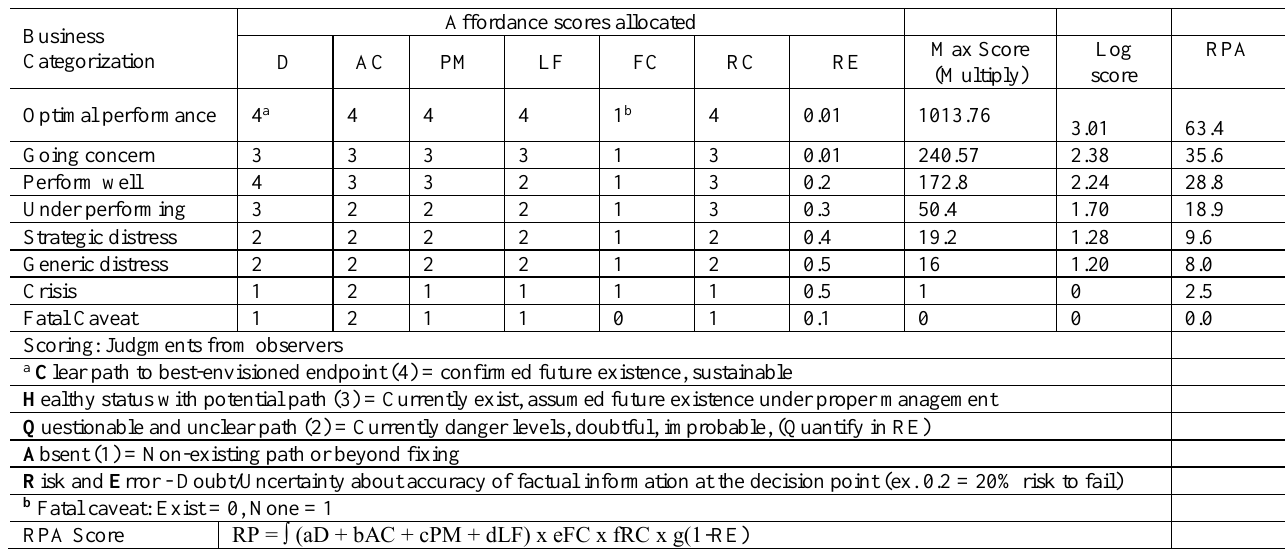
Table I: Application of the reasonable prospect assessment (RPA) score for different turnaround situations when operating in the